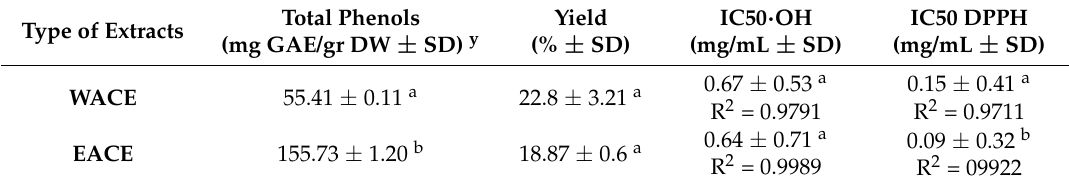
Table 1. Yield extraction (%), total phenols and EPR-spin trapping and DPPH-radical scavenging activity (IC50) of ethanolic and water crude extracts obtained by accelerator solvent extraction (ASE). Type of Extracts